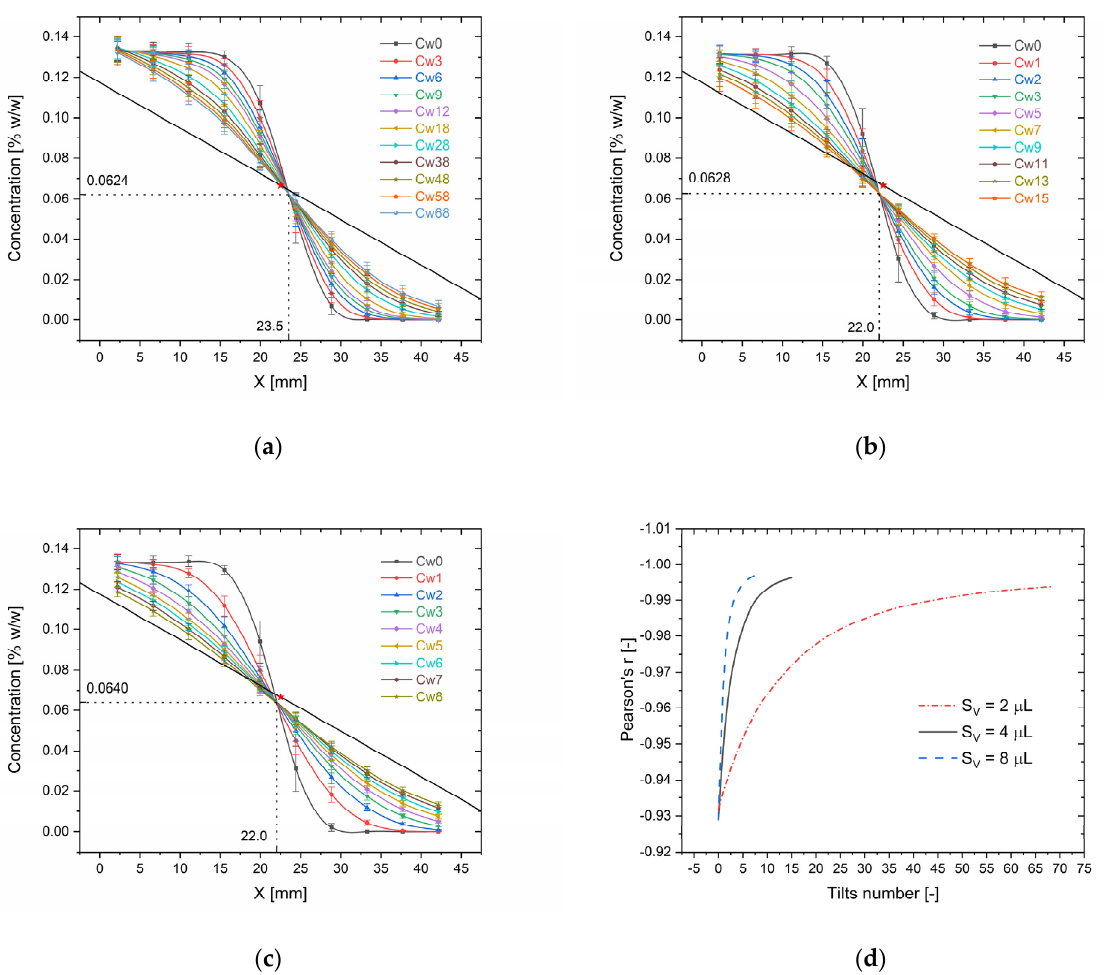
Figure 4. Analysis of influence of tilts number on gradient linearity C MAX = 0.1333, C MIN = 0 [% w / w ]: ( a ) The distribution of the methylene blue concentration along CC for different numbers of tilts and (1.0 + 1.0) µ L SV; ( b ) The distribution of dye concentration for (2.0 + 2.0) μ L SV; ( c ) The distribution of dye concentration for (4.0 + 4.0) μ L SV; ( d ) Dependence of Pearson’s correlation coefficient ( P r ) on number of device tilts ( T N ) for different SV. The straight line on Figures ( a – c ) with a red star dot (center mark) represents the theoretical dye concentration profile.